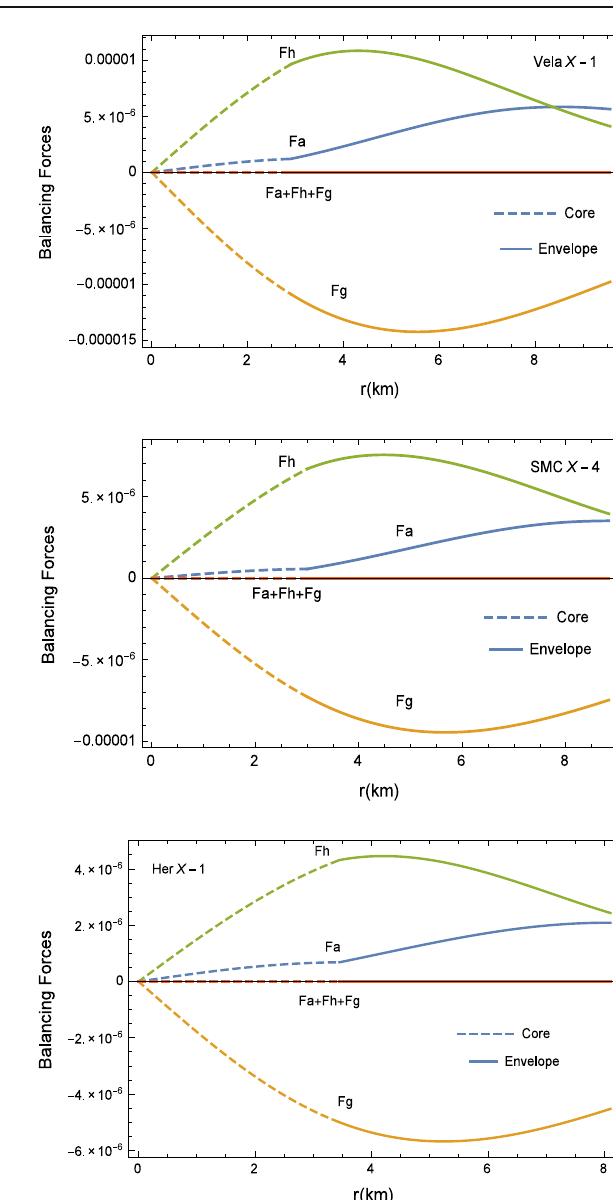
Fig. 12 Variation of balancing forces with radial coordinate r for (i) the neutron star in Vela X-1(upper) (ii) SMC X-4 (middle) (iii) Her X-1